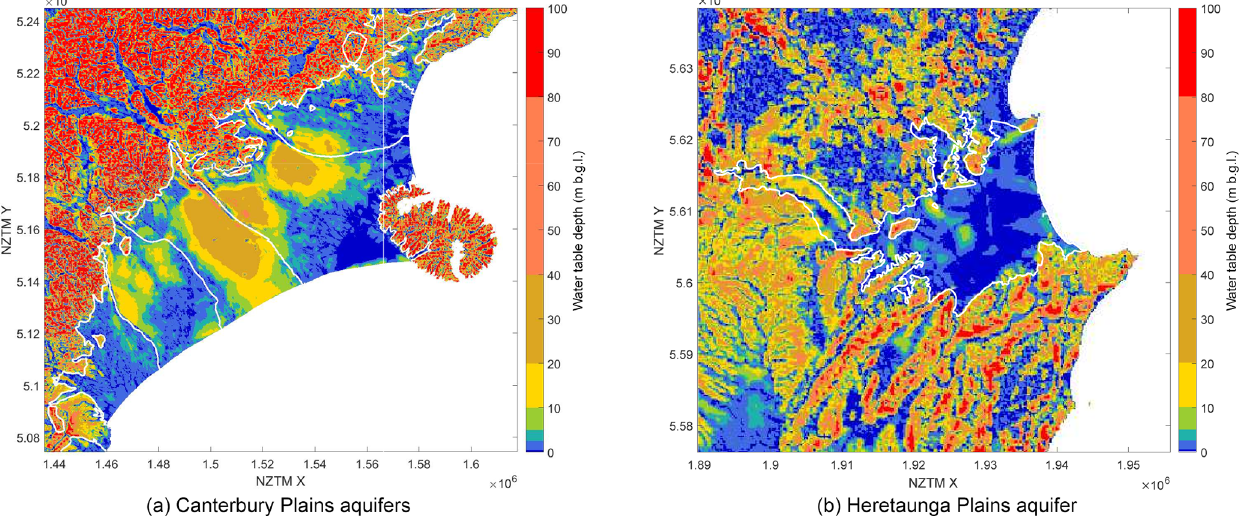
Figure 6. NWT water table depth and aquifer boundaries of White (2001) (white